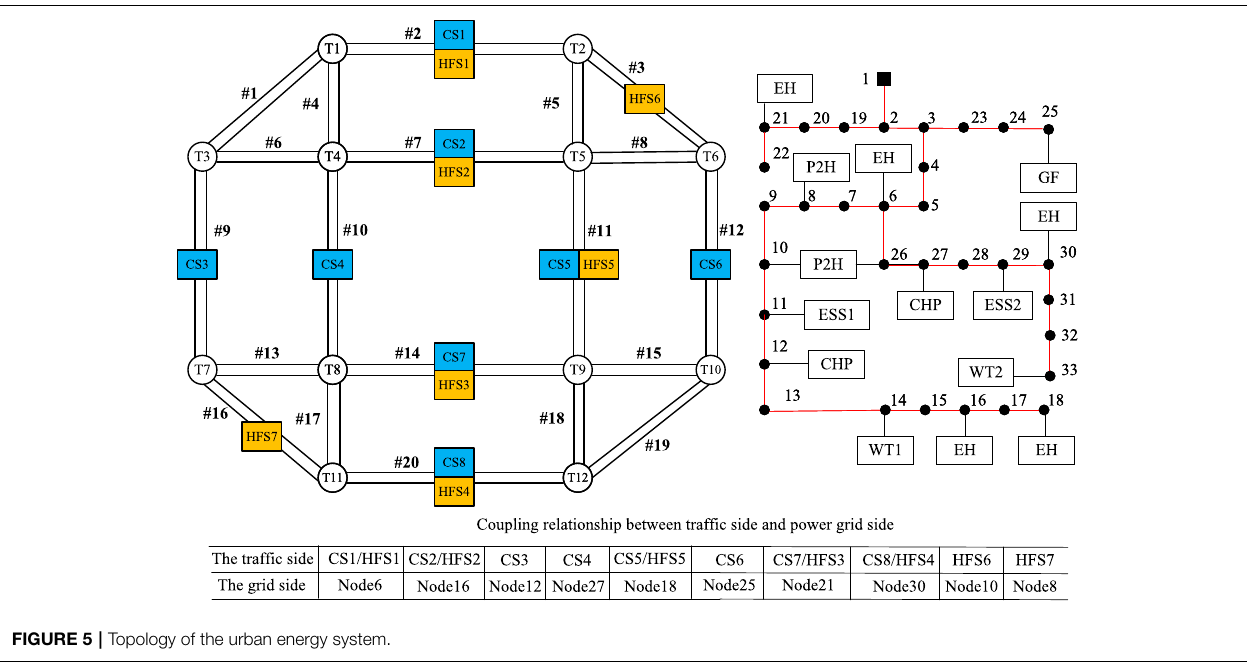
FIGURE 5 | Topology of the urban energy system.